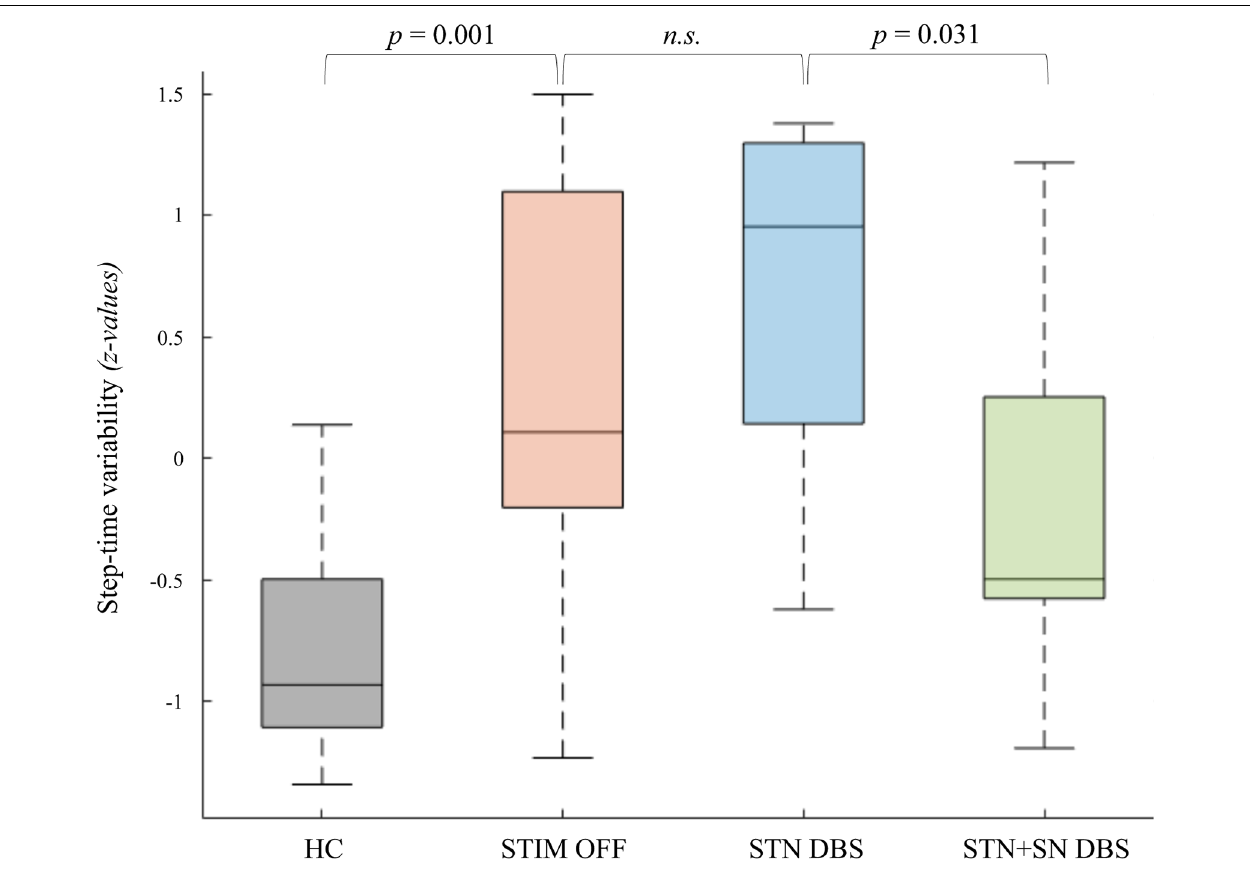
FIGURE 2 | Deep brain stimulation (DBS) effects on step-time variability of the more affected leg. The coefficients of variability of step-to-step time in healthy controls and Parkinson’s disease (PD) patients in the three DBS conditions are displayed as boxplots. The values reported in the boxplots are median, interquartile range (IQR), whiskers (highest/lowest values of the data-set within 1.5 times of the IQR). Values reported above are significant p -values of planned post-hoc t